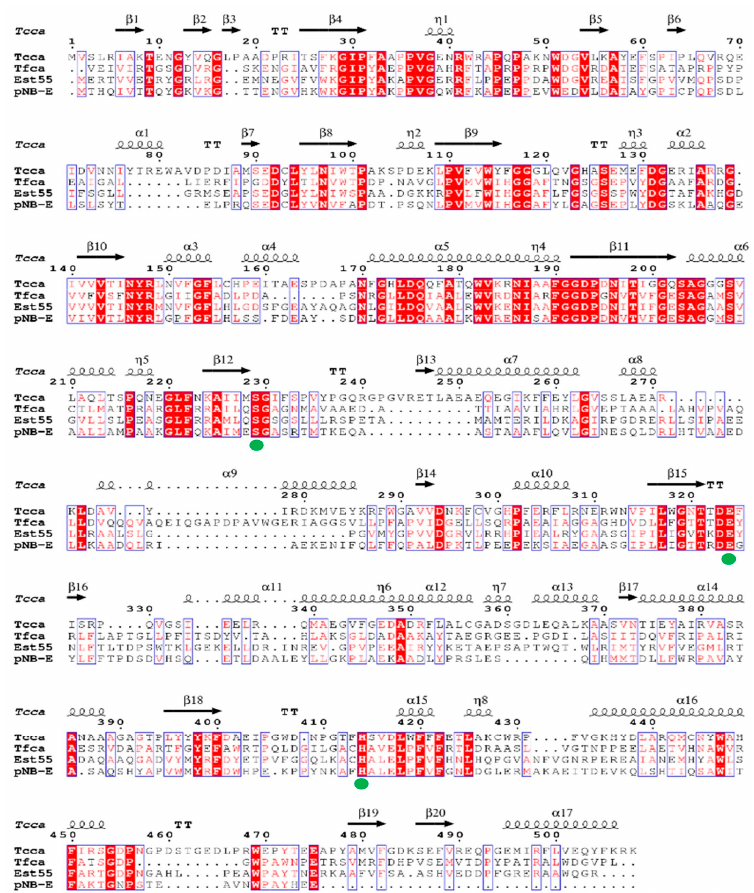
Figure 2. Amino acid sequence alignment of Tcca with homologous enzymes. Alignment of the carboxylesterase sequences used in the consensus analysis. The sequence alignment of Tcca was carried out with carboxylesterases TfCa from T . fusca (PDB: 7W1K), Est55 from G. stearothermophilus (PDB: 2OGS), and a pNB–E from B. subtilis (PDB: 1QE3). Strictly conserved residues are highlighted in a red background, and catalytic triad consisting residues are represented by green dots. A secondary structure topology based on the structure of Tcca modeling is shown on top of the sequence align- ment. 2.2. Characterization of Tcca Tcca was successfully over–expressed in the E. coli BL21 (DE3) and purified to ho- mology using a nickel affinity column. The melting temperatures ( T m ), optimum temper- ature and pH of Tcca were determined using the purified protein (Figure 3). The T m of Tcca is determined to be 70.07 °C (Figure 3A), suggesting that it has a high thermal stabil- ity. The effect of temperature on Tcca activity was explored at various temperatures rang- ing from 30 to 70 °C, and Tcca exhibited the maximum enzyme activity at 40 °C, but it still retained a 50% relative activity at 30 and 50 °C (Figure 3B). The relative enzyme activity of Tcca was stable in the pH range of 6.0–8.0, with an optimum pH of 7.0 (Figure 3C).